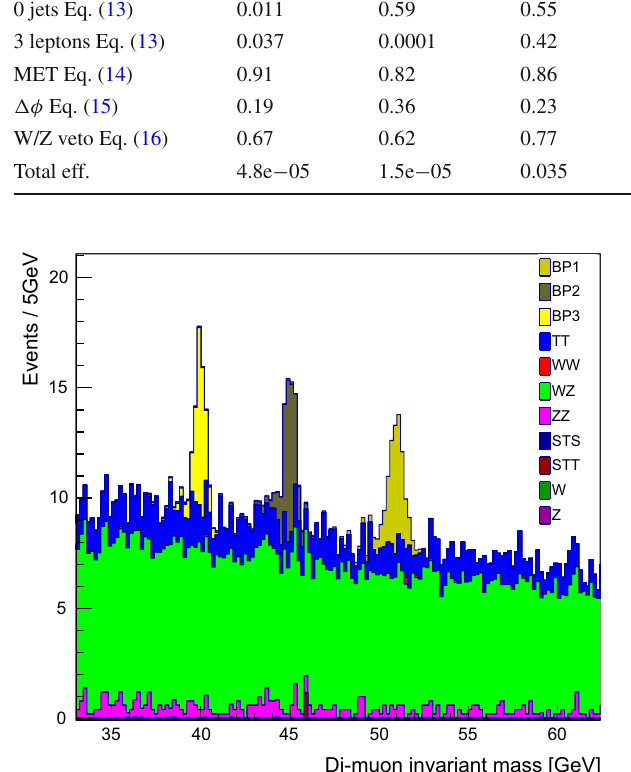
Fig. 10 The distribution of di-lepton pair invariant mass in signal ( (cid:2)(cid:2) H (cid:2)ν H ) and background